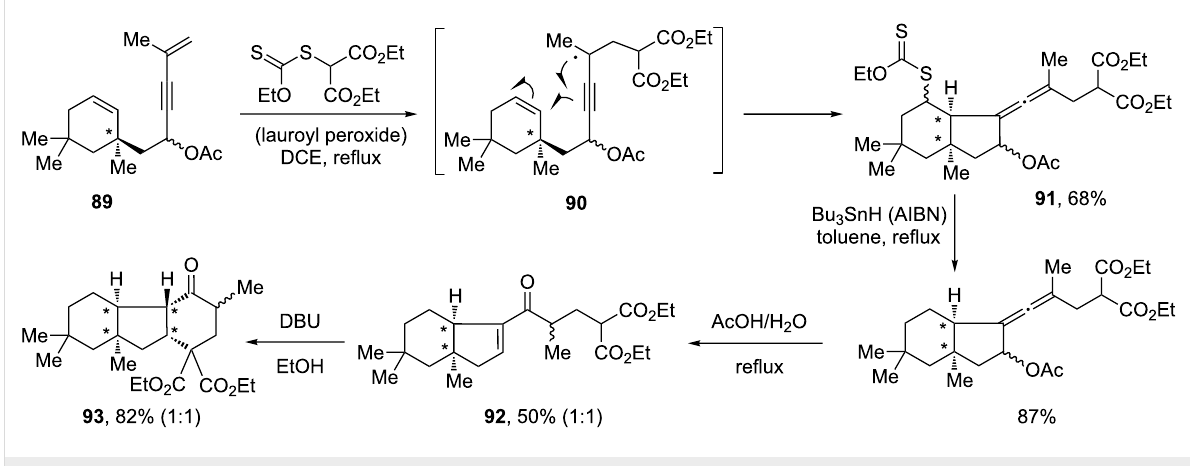
Scheme 18: Formation of a polycyclic structure via an allene intermediate.